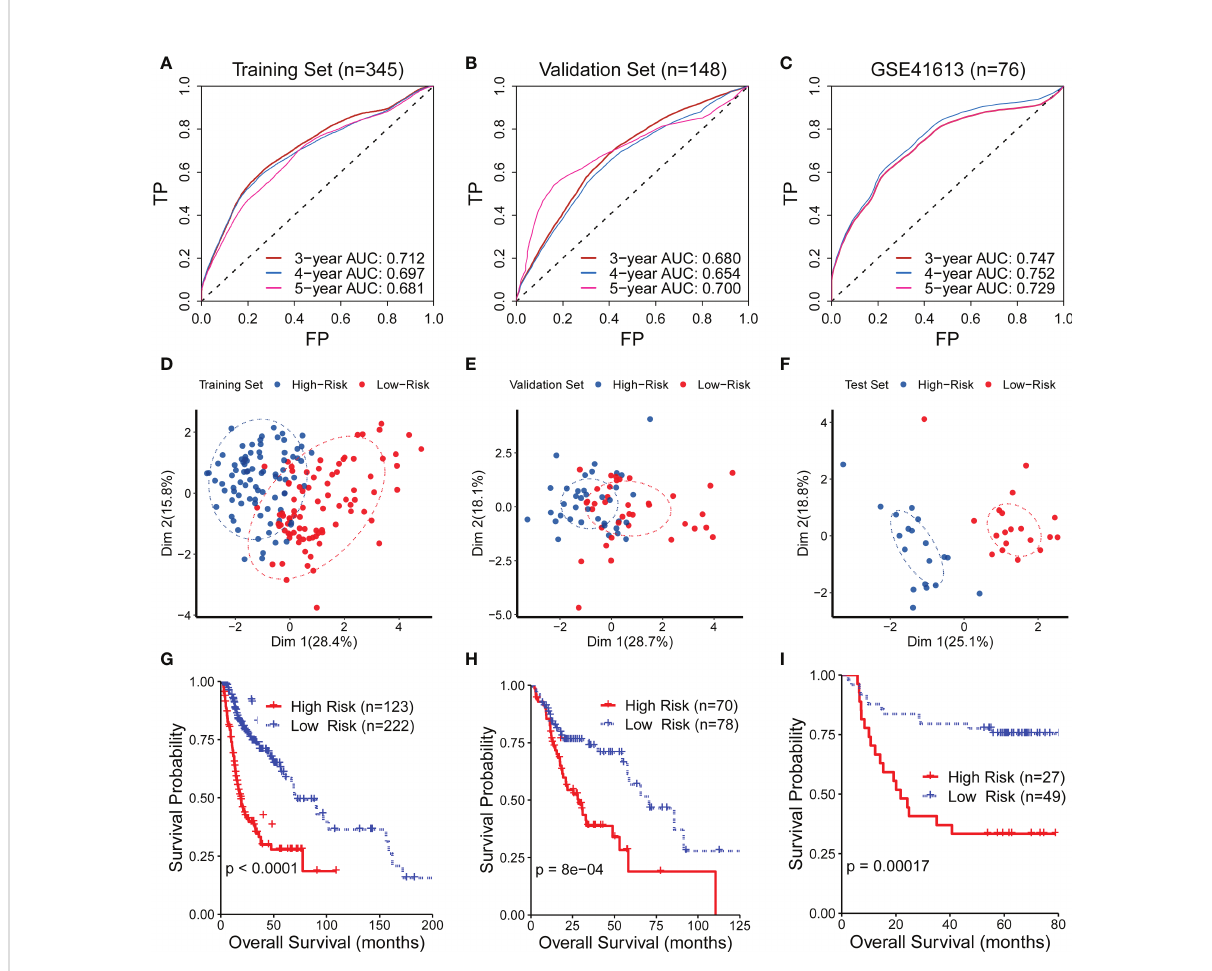
FIGURE 2 Evaluation of the performance of the circadian rhythm-related gene signature. (A – C) The area under the receiver operating characteristic curve (AUC) values for predicting the 5-year overall survival (OS) were 0.681, 0.700, and 0.729 in the training set, validation set, and test set, respectively. (D – F) The principal component analysis showed that the low-risk patients were distinct from the high-risk patients in Dim 1 in the training set, validation set, and test set. (G – I) The survival analysis also revealed that the low-risk group had an improved OS compared with the high-risk group in the training set, validation set, and external test